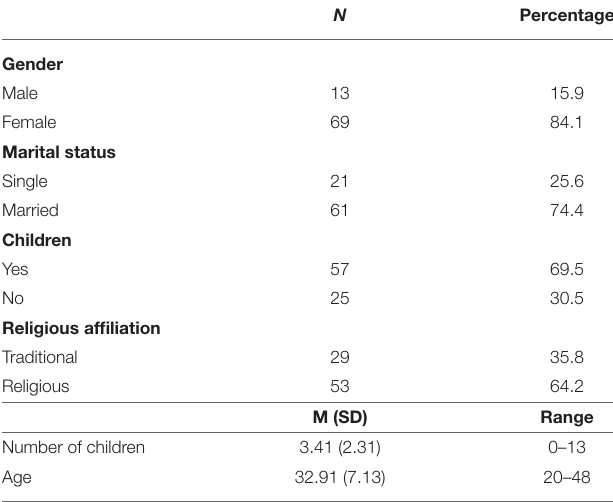
TABLE 1 | Participants’ background variables ( N =